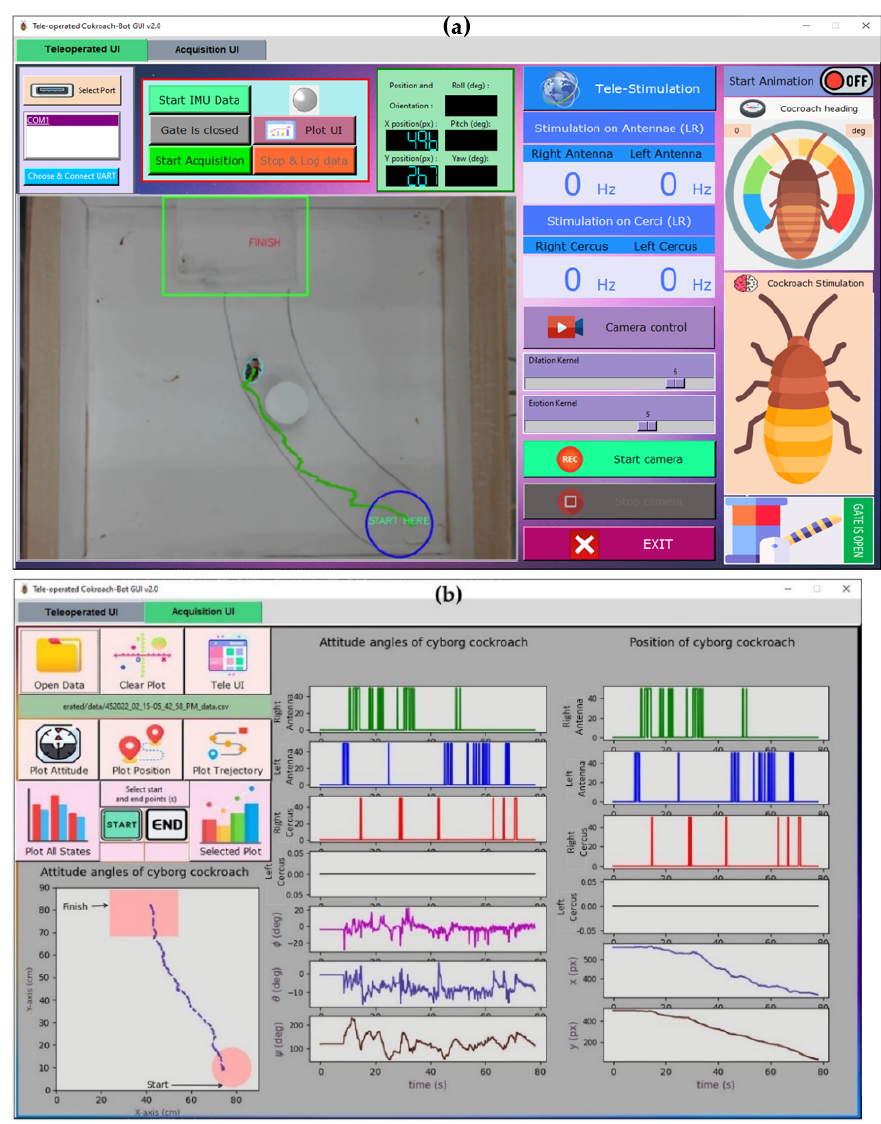
Figure 6. Local user interface in Japan: ( a ) teleoperation interface, ( b ) plotting purpose.